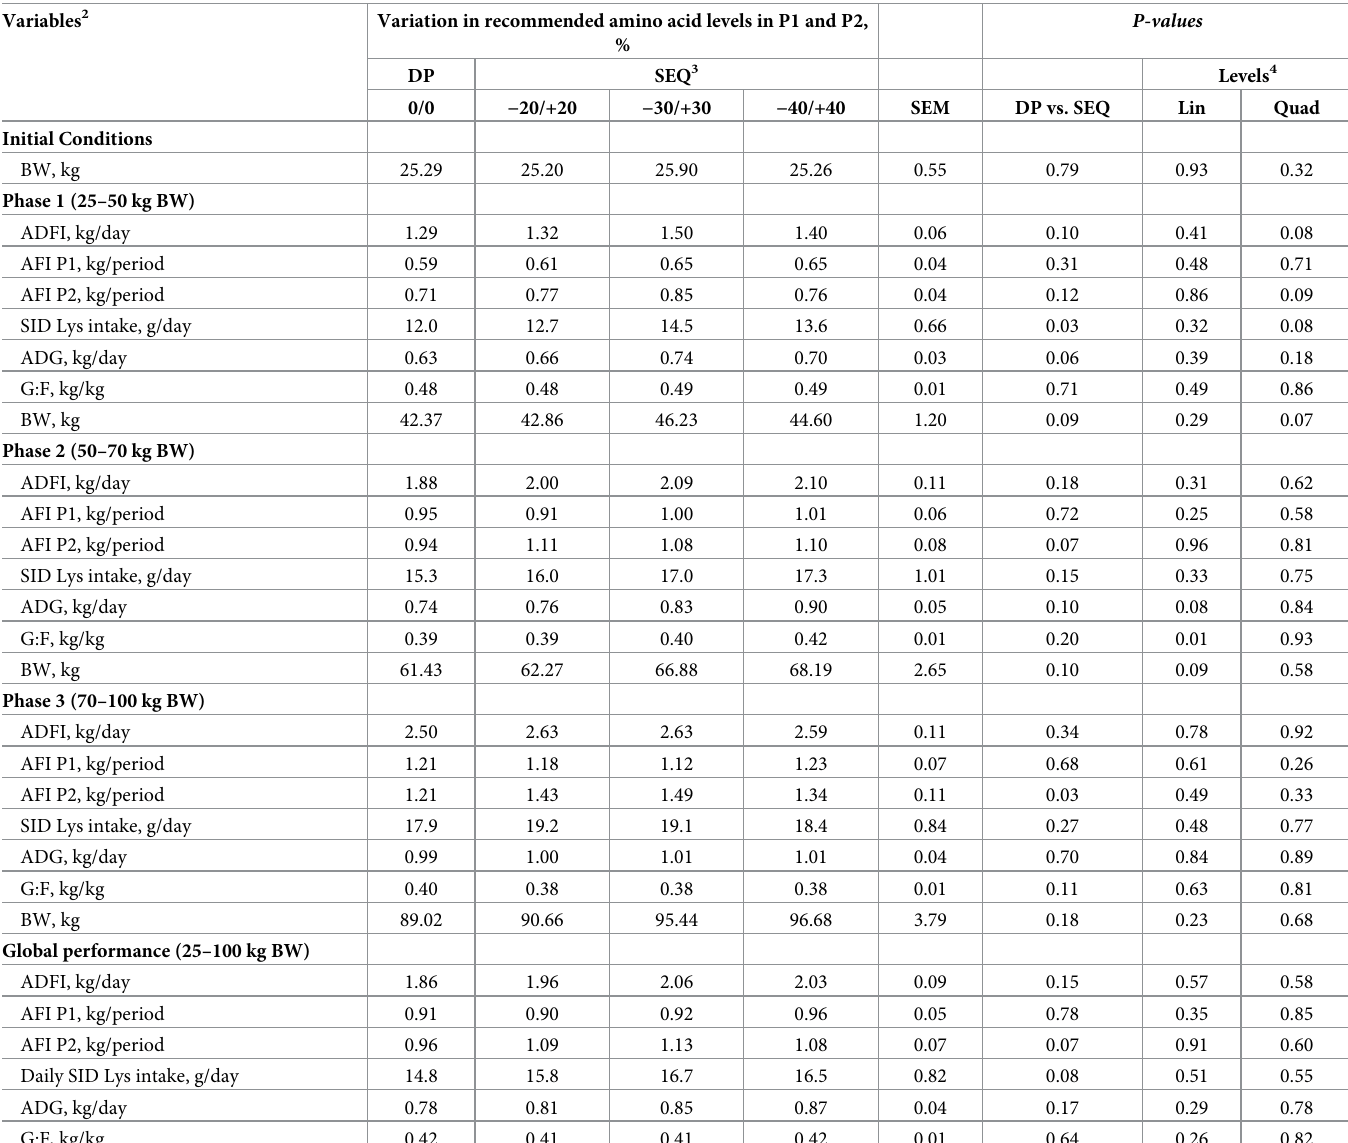
Table 2. Performance of pigs in a daily feeding program (DP) or in a sequential feeding program (SEQ) with different levels of variation in amino acid (AA) con- centration throughout the day 1 . Variables